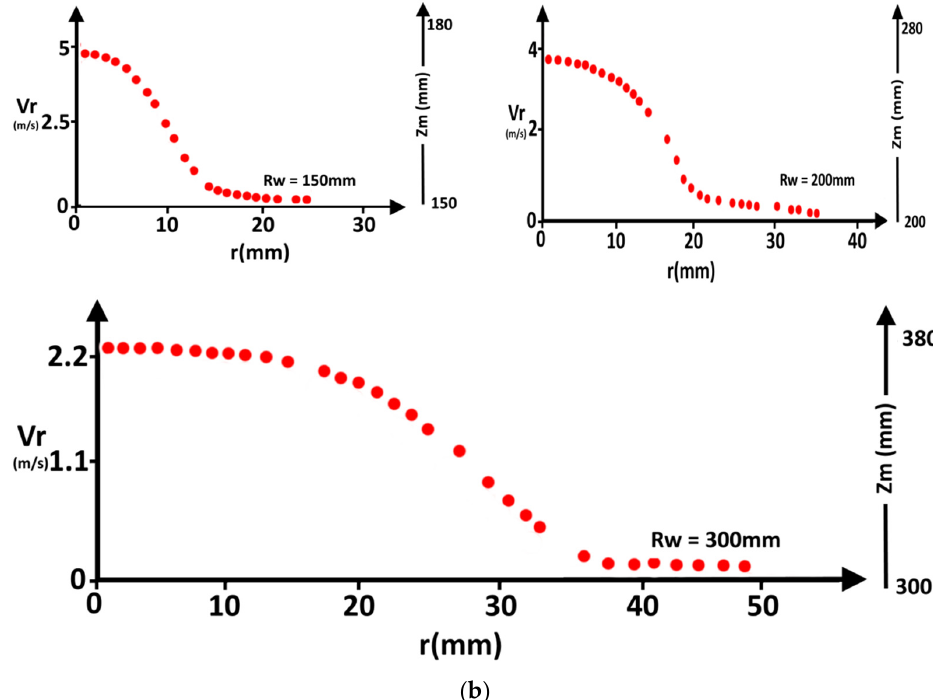
Figure 6. ( a ) Mean axial velocity at G = 295 kg/m 2 s and T = 50 °C. ( b ) Mean axial velocity at G = 672 kg/m 2 s and T = 50 °C.